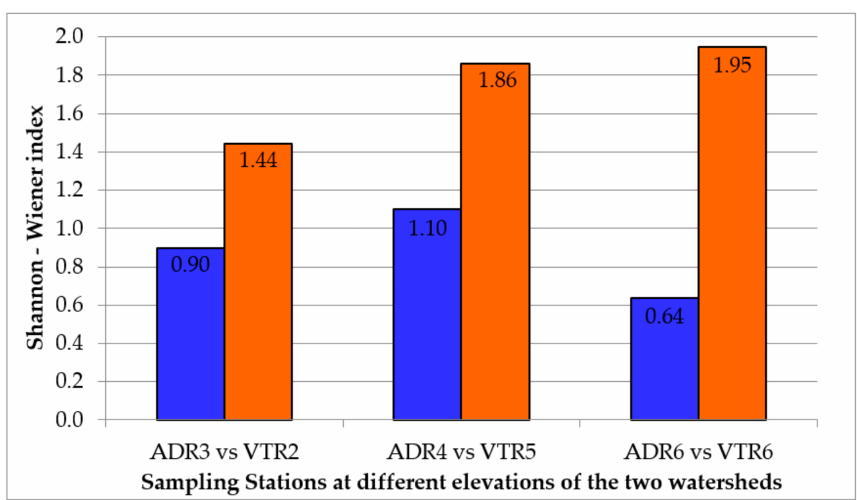
Figure 7. The Shannon–Wiener diversity index for all sampling station where insects were collected for Arkoudorema (ADR) (blue column) and Vathirema (VTR) (orange column).